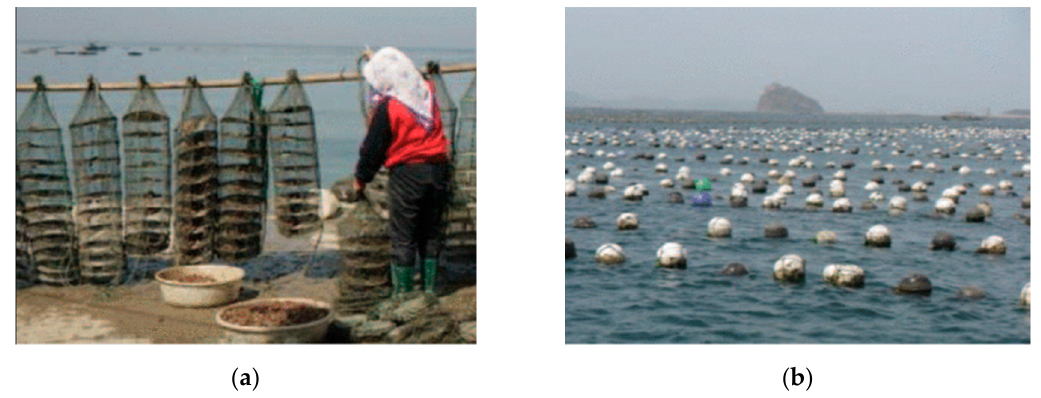
Figure 1. Raft culture. A floating raft has two parts: underwater ( a ) and water ( b ) [5].